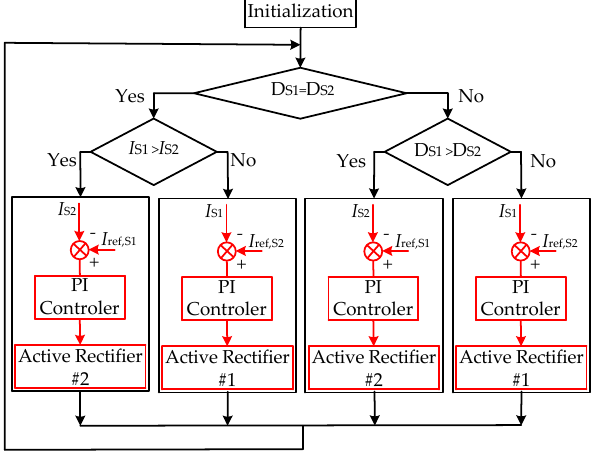
Figure 8. Flow chart of the current tracking control.